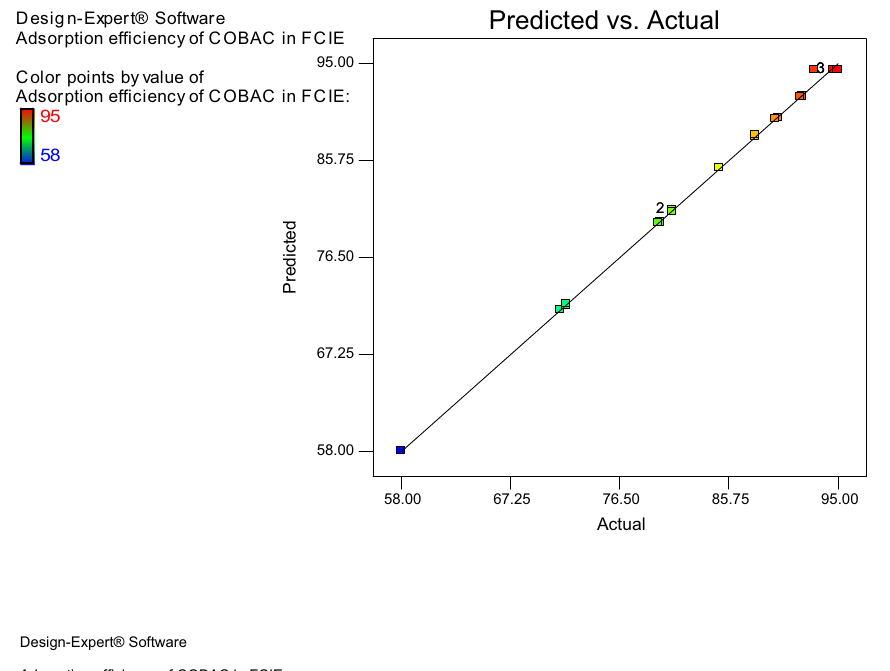
Fig. 3 3D plot showing the effect of pH and adsorbent dosage on adsorption efficiency in the treatment of fibre cement industry effluent using coal-